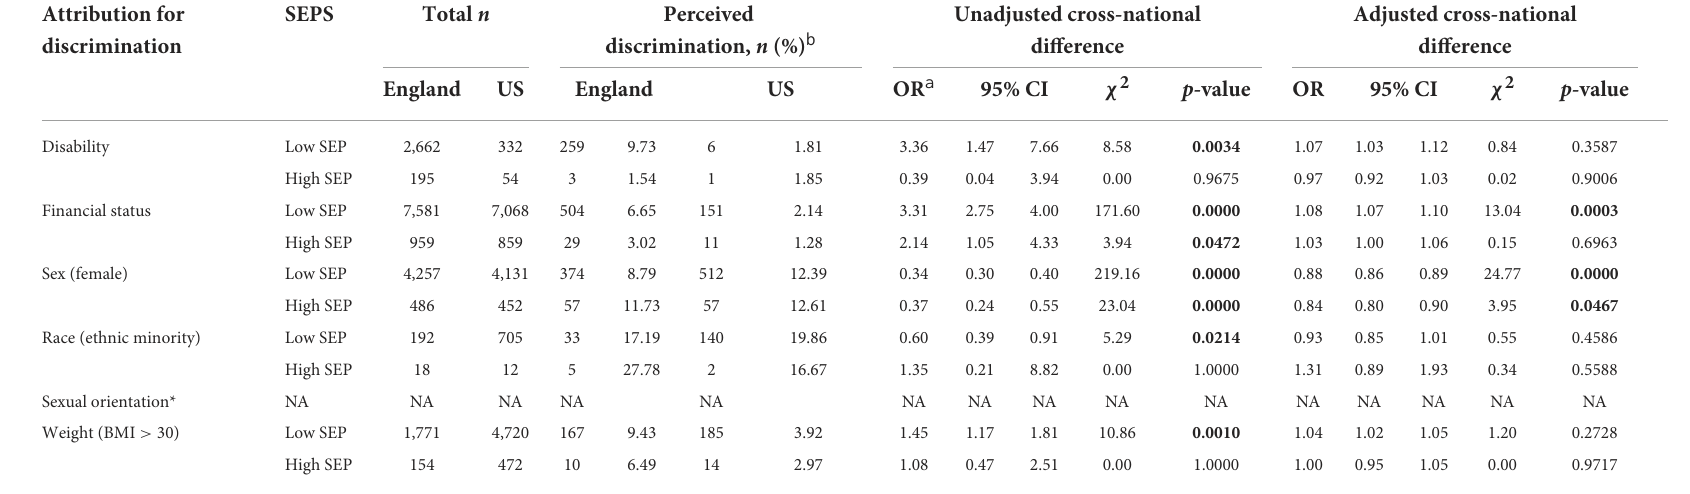
TABLE 3 Prevalence and cross-national differences in perceived discrimination attributed to disability, financial status, sex, race, sexual orientation, and weight stratified by socioeconomic position (SEP). Attribution for SEPS Total n Perceived Unadjusted cross-national Adjusted cross-national discrimination discrimination, n (%)